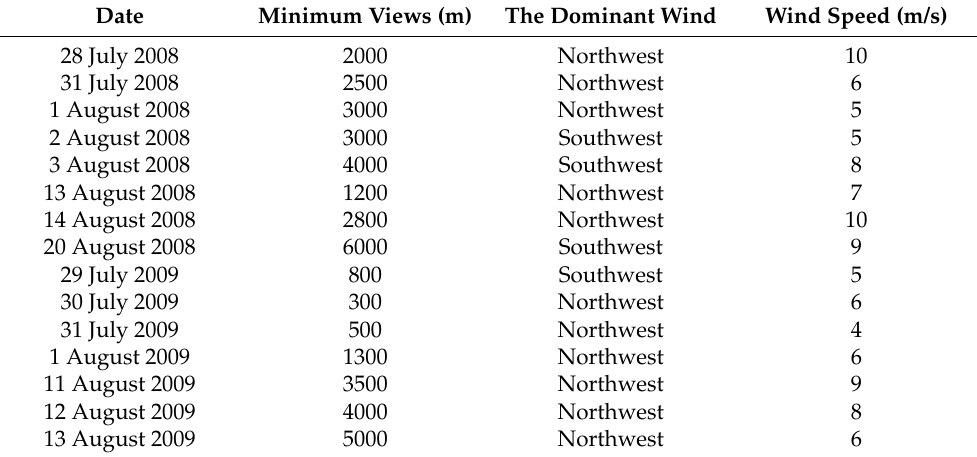
Table 1. The rate of horizontal and wind direction in August 2008 (high) and 2009 (lower), during days that dust is